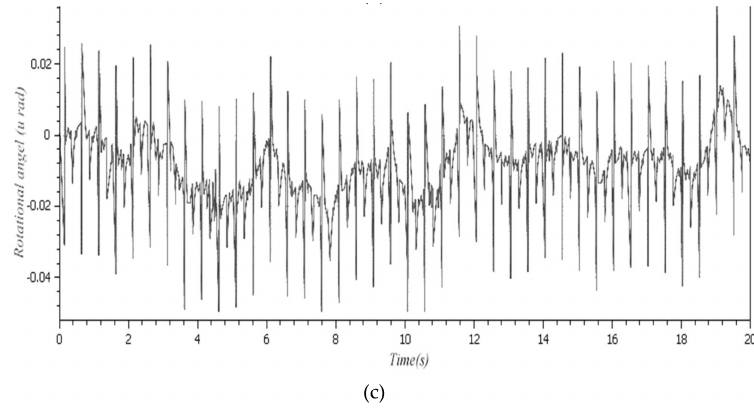
Figure 11. Displacement of three rotational directions along x − y − z axes; ( a ) Around x -axis, ( b ) Around y -axis, ( c ) Around z -axis.